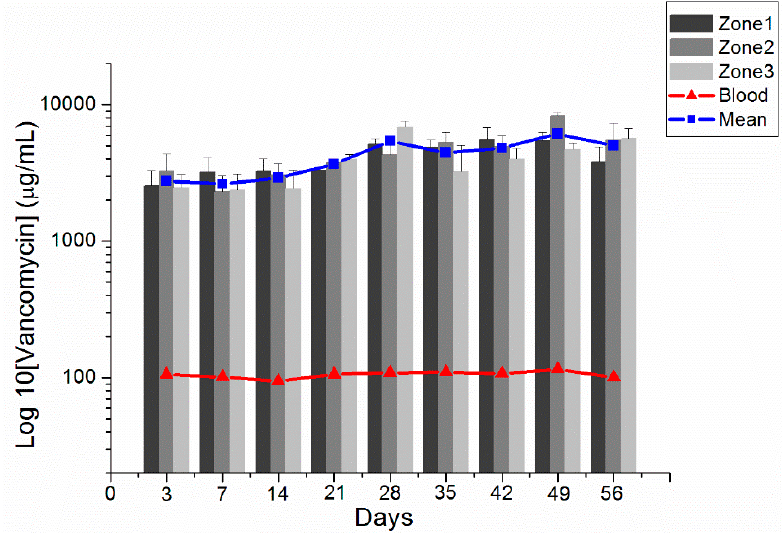
Figure 5. In vivo release . In vivo release of vancomycin from biodegradable antibiotic-embedded microparticles and concentrations in various zones of the brain parenchyma and blood (error bars indicate standard deviation).